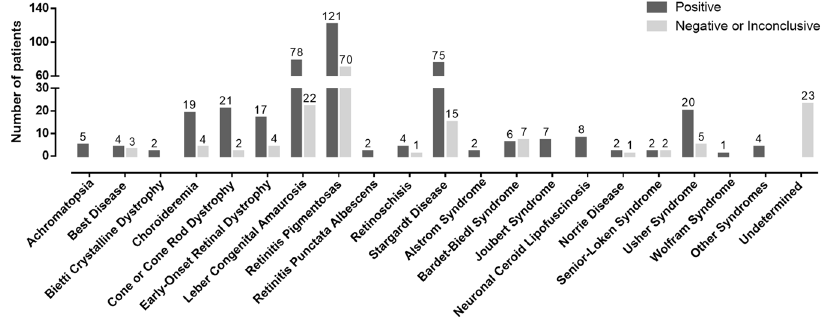
Figure 2. The distribution of positive and negative/inconclusive tests according to the IRD type (n = 559; 400 positive and 159 negative/inconclusive